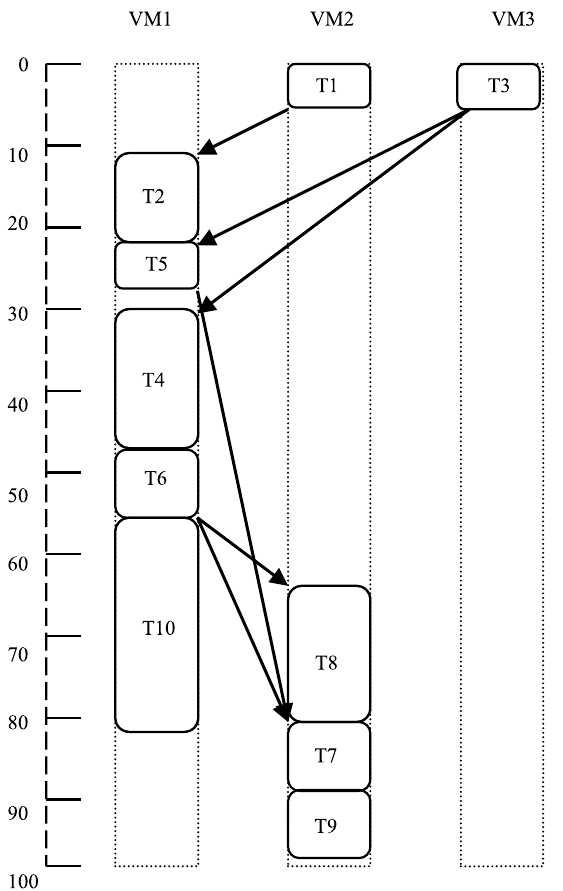
Fig.6 Scheduling of DAG with modified HEFT Algorithm. (Use of minimum computation cost in rank calculation & schedule length is 98)